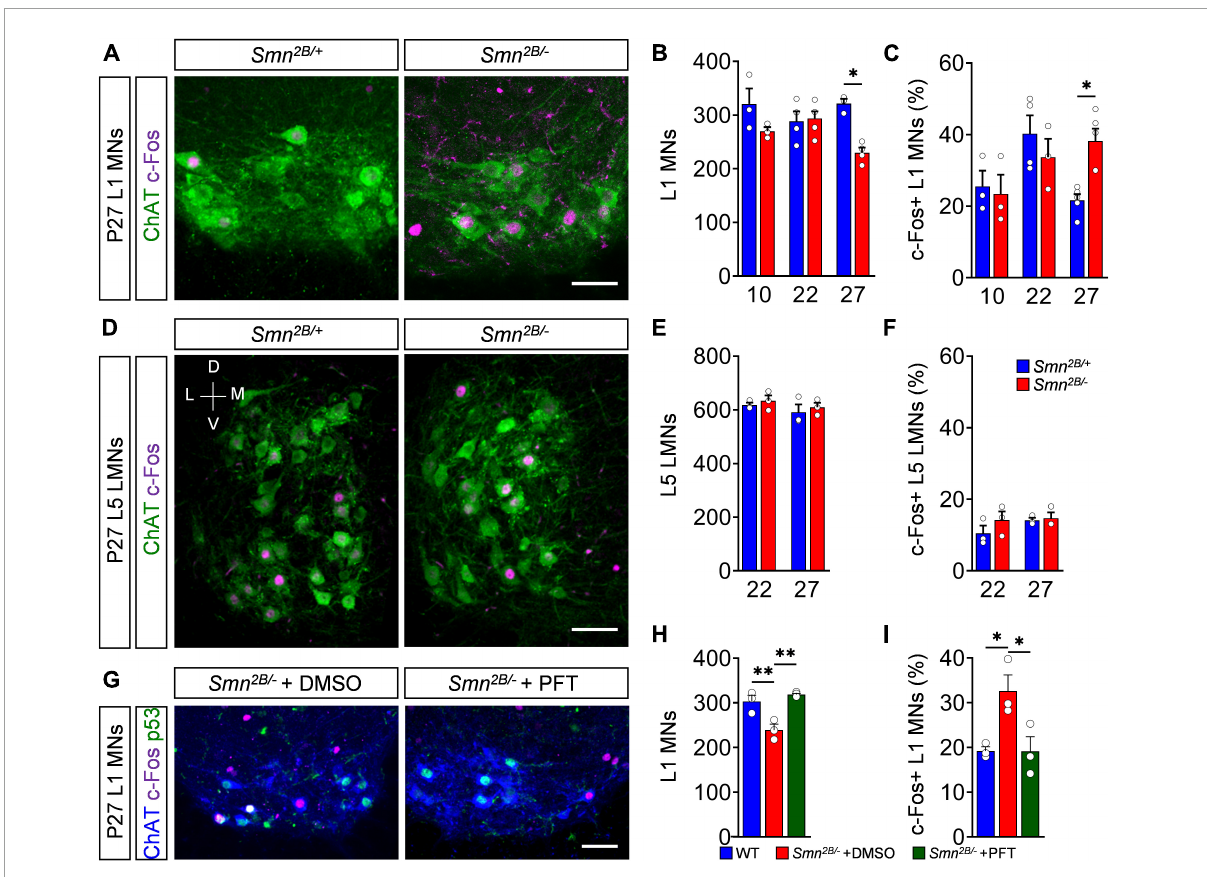
FIGURE5 p53-dependent c-Fos upregulation marks motor neuron death in an intermediate spinal muscular atrophy (SMA) model. (A) Immunostaining of c-Fos (magenta) and ChAT + (green) L1 motor neurons (MNs) from P27 control ( Smn 2 B / + ) and SMA ( Smn 2 B / - ) mice. Scale bar = 50 µ m. Quantification of L1 (B) MN number and (C) c-Fos positive MNs in% of P10, P22 and P27 Smn 2 B / + and Smn 2 B / + mice. n = 3–4 per genotype. (D) Immunostaining of c-Fos (magenta) and ChAT + (green) L5 lateral motor neurons (LMNs) from P27 Smn 2 B / + and SMA Smn 2 B / - mice. Scale bar = 100 µ m. V, ventral; D, dorsal; M, medial; L, lateral. Quantification of L5 LMN (E) MN number and (F) c-Fos positive MNs in% of P10, P22 and P27 Smn 2 B / + and Smn 2 B / - mice. n = 3 per genotype. (G) Immunostaining of c-Fos (magenta), p53 (green) and ChAT + (blue) L1 motor neurons (MNs) from P27 Smn 2 B / - chronically treated with DMSO or Pifithrin- α (PFT). Scale bar = 100 µ m. Quantification of L1 (H) MN numbers and (I) c-Fos positive MNs in% of P27 Smn 2 B / + and Smn 2 B / - mice treated with DMSO or PFT. n = 3 per genotype. Statistics: two-way ANOVA with Tukey’s correction for panels (B,C,E,F) . One-way ANOVA with Tukey’s correction for panels (H,I) . Each data point (n) represents one animal. Asterisks on top of bars without horizontal line indicate the significance compared to another group. * p < 0.05; ** p <